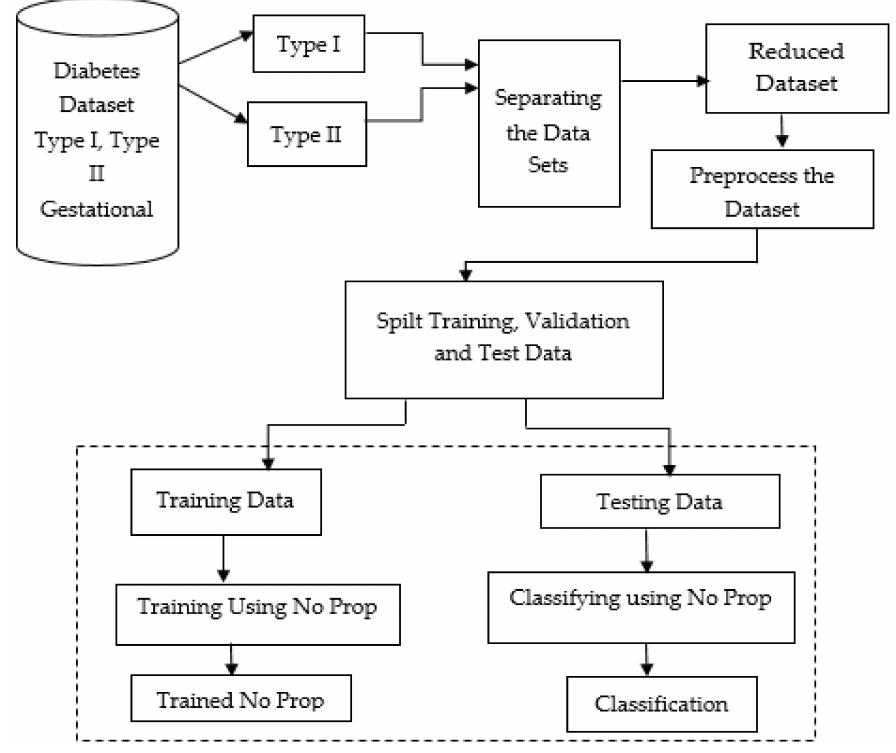
Figure 1. Proposed no-prop multi-layer neural network